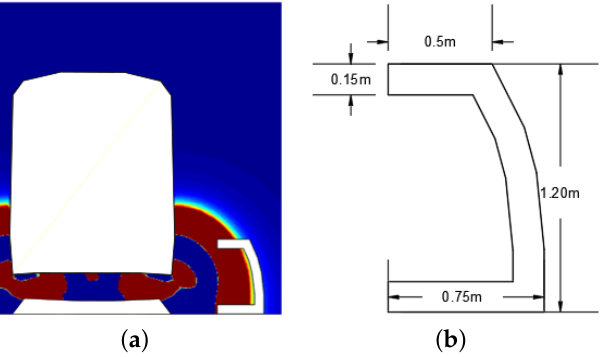
Figure 12. ( a ) Schematic representation of the wave front and the designed barrier; ( b ) representation of the main dimensions of the final